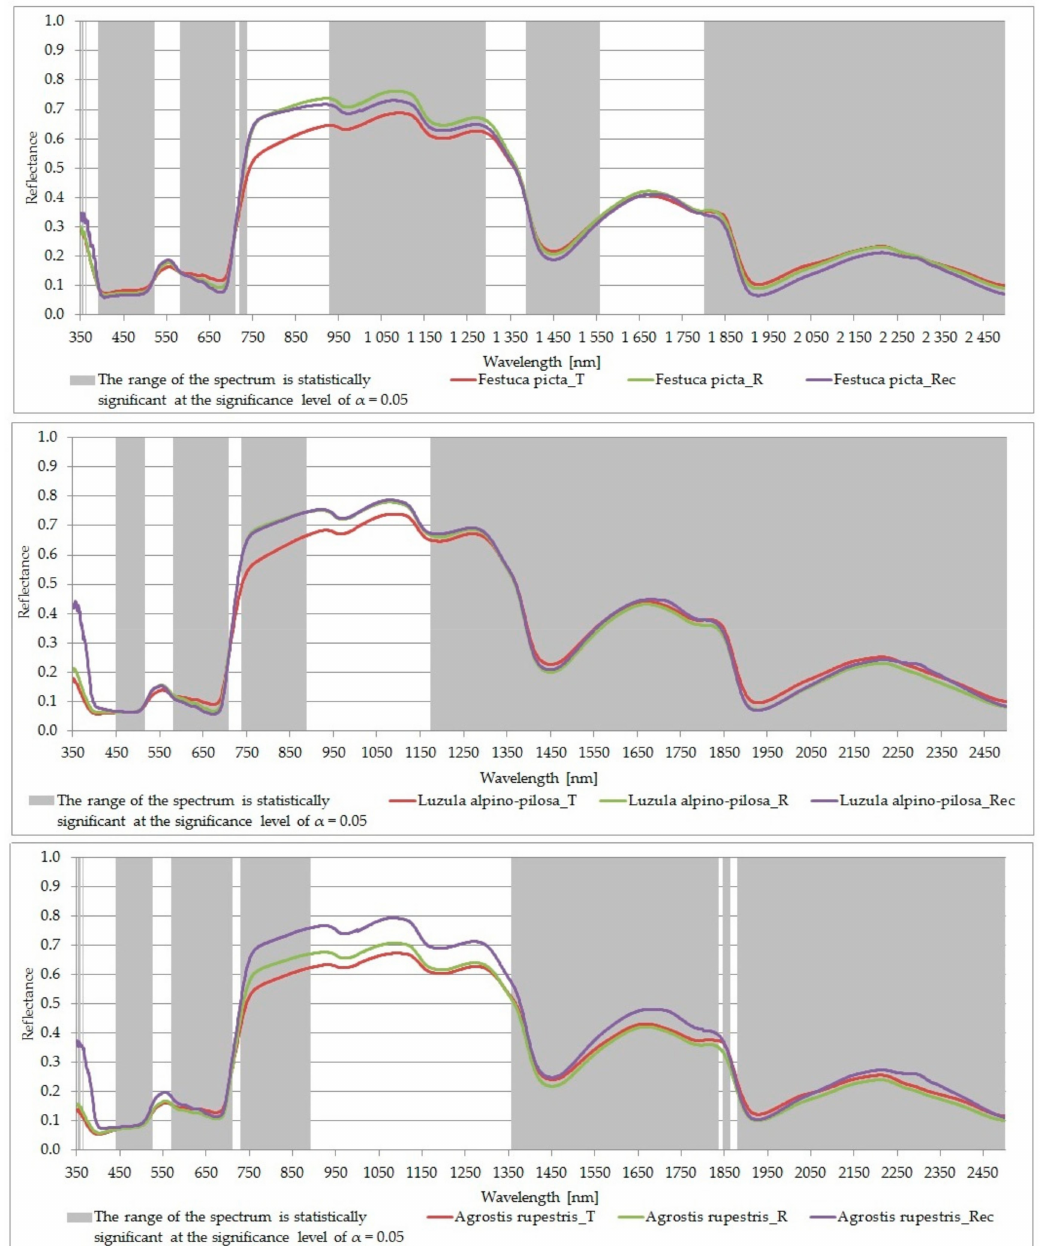
Figure 4. Mean value for the spectral properties of the Festuca picta , Luzula alpino-pilosa , Agrostis rupestris tested with the shaded parts of the electromagnetic spectrum indicating where a significant statistical relationship at the 0.05 level was found (test ANOVA, α = 0.05), n = 49,375 per species. The area marked in gray is a common part of the di ff erences between polygons for the values of spectral characteristics. Summing up, it should be noted that spectral characteristics of the dominant alpine sward species demonstrate the condition of the vegetation, which may be deemed good in the case of reference and recultivated vegetation (as no changes in the red edge range were detected). Flattening is